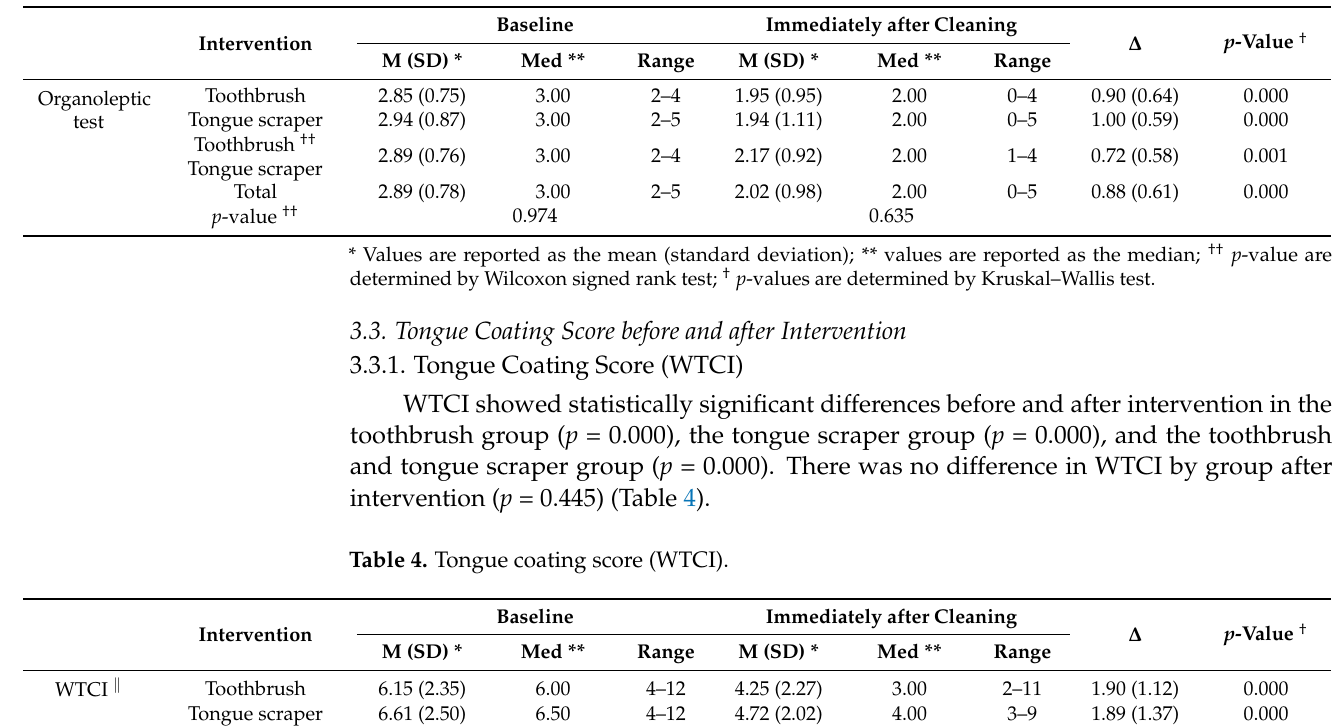
Table 3. Organoleptic test score.